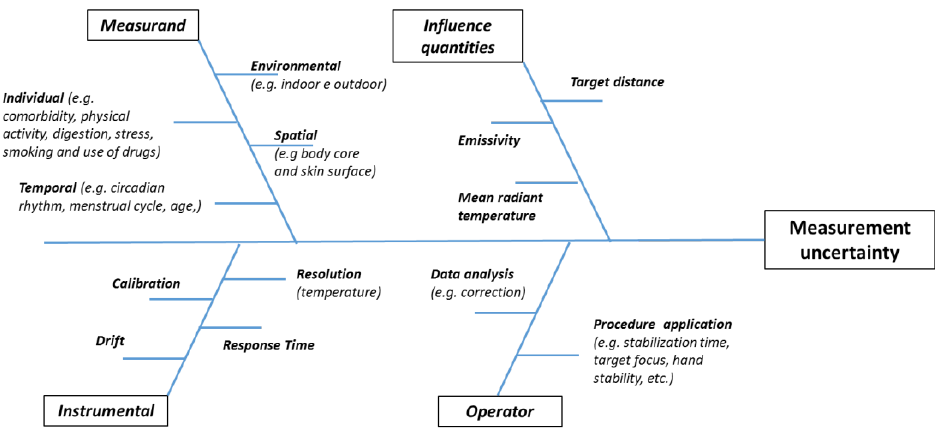
Figure 2. Root causes of noncontact temperature measurement uncertainty.